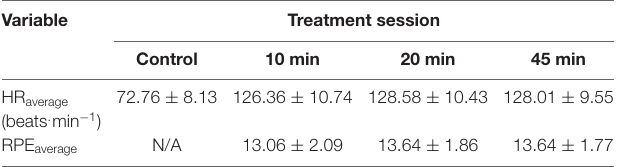
TABLE 2 | Descriptive data of exercise manipulation check (M ±